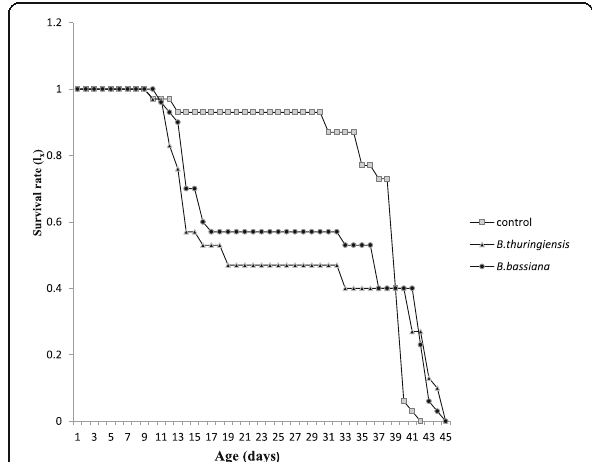
Fig. 1 Age-specific survivorship ( l x ) of T. absoluta treated as second instar larvae by LC 50 values of B. thuringiensis or B. bassiana